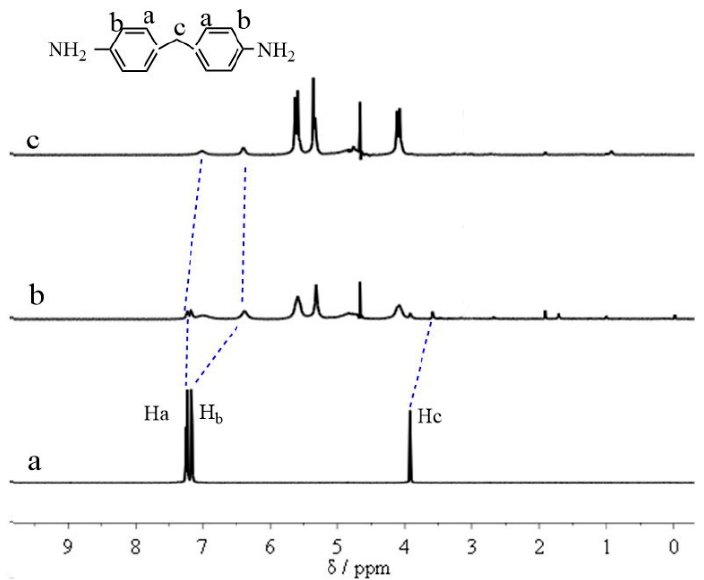
Figure 6. The 1 H NMR titration of 0.1 mM solution of ( a ) free guest MDA; ( b ) N (Q[7]) /N (MDA) = 2; ( c ) N (Q[7]) /N (MDA) = 4.